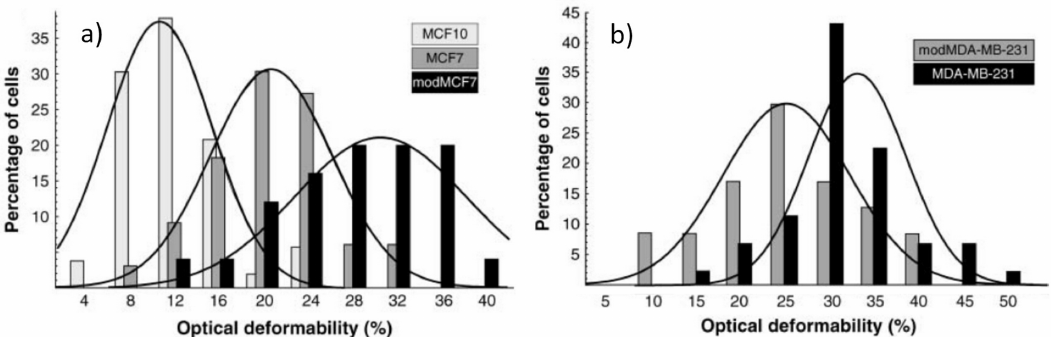
Figure 15. Optical deformability of normal, cancerous, and metastatic breast epithelial cells. ( a ) The three populations of the MCF cell and ( b ) the two populations of the MDA-MB-231 cell are clearly distinguishable. Curves represent the fitting of normal distribution. Figure reproduced with permission from Reference [23] with permission from Prof.